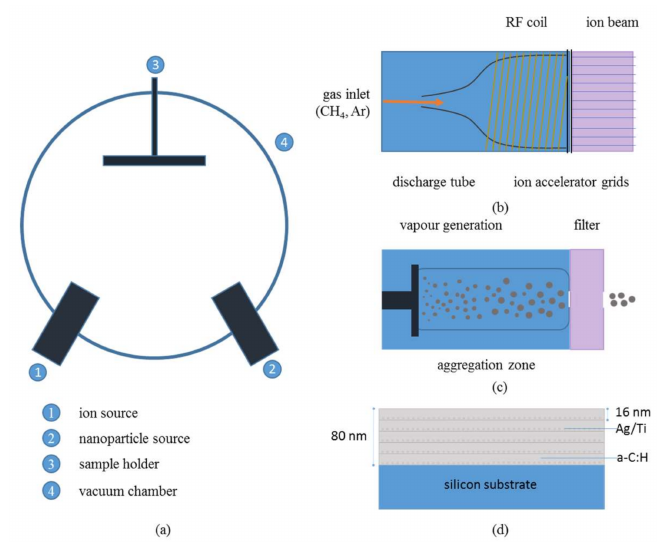
Figure 1. ( a ) Schematic of the hybrid PECVD/PVD system used within this study; Details of ( b ) the ion source and ( c ) the nanoparticle source; ( d ) Schematic of the metal containing hydrogenated